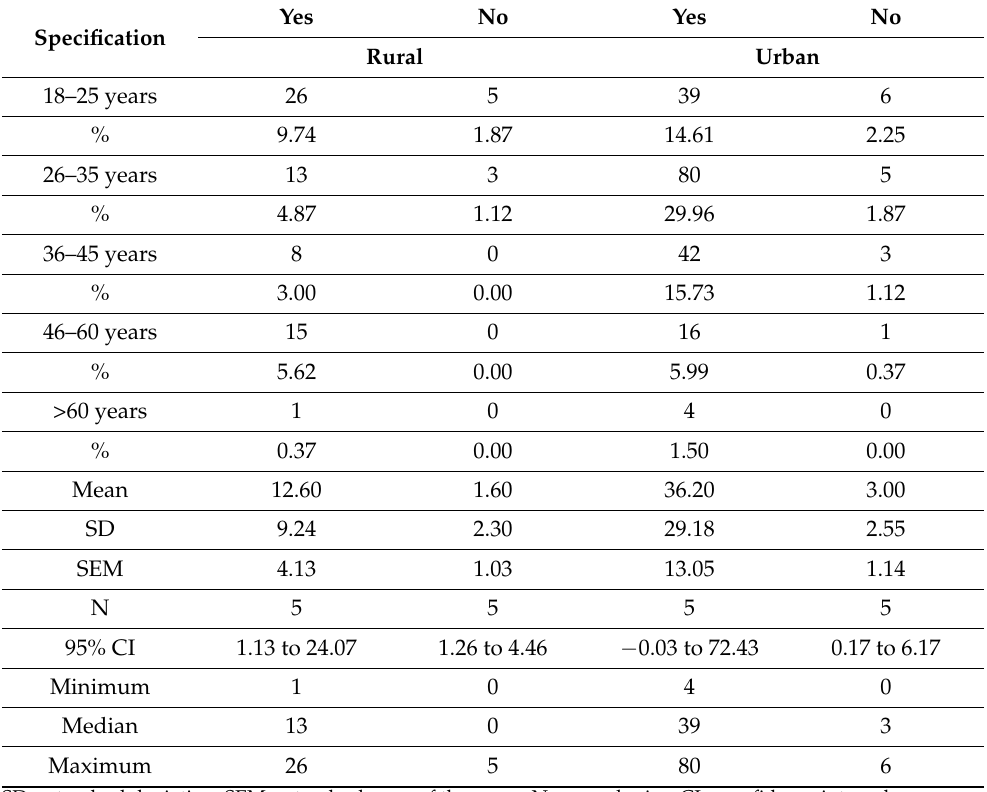
Table 8. Consumers interested or not in food waste, depending on age and housing environment,